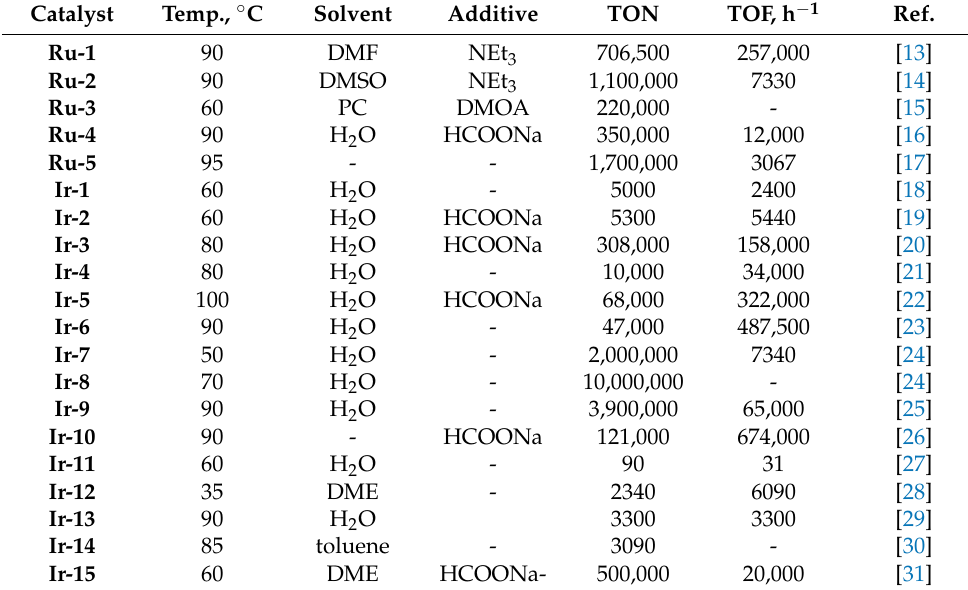
Table 1. Selected precious metal catalysts for FADH.